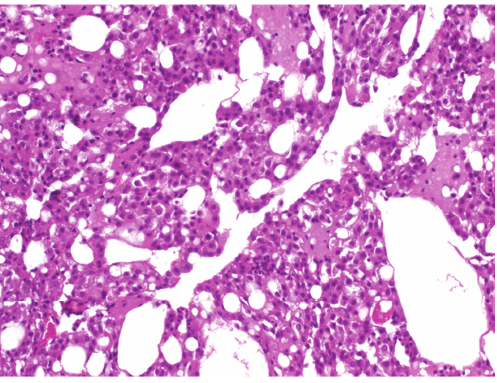
Figure 1: Picture shows epithelial cells arranged in strands and gland-like structures with eosinophilic cytoplasm and small dark staining nuclei.